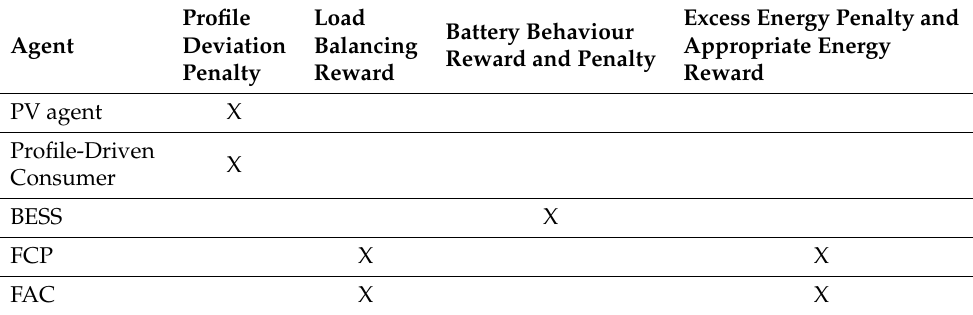
Table 3. Agents and reward